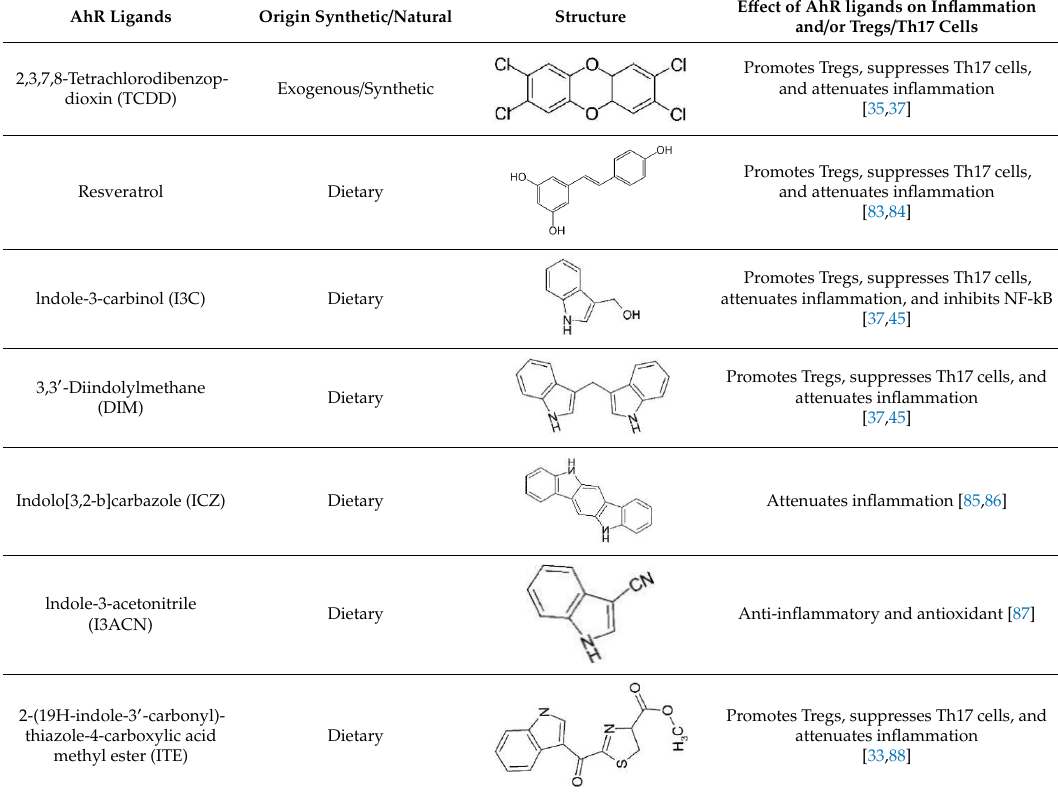
Table 1. Natural and Synthetic AhR ligands and their effects on inflammation. It should be noted that some ligands may also act directly through other pathways such as NF-kB.